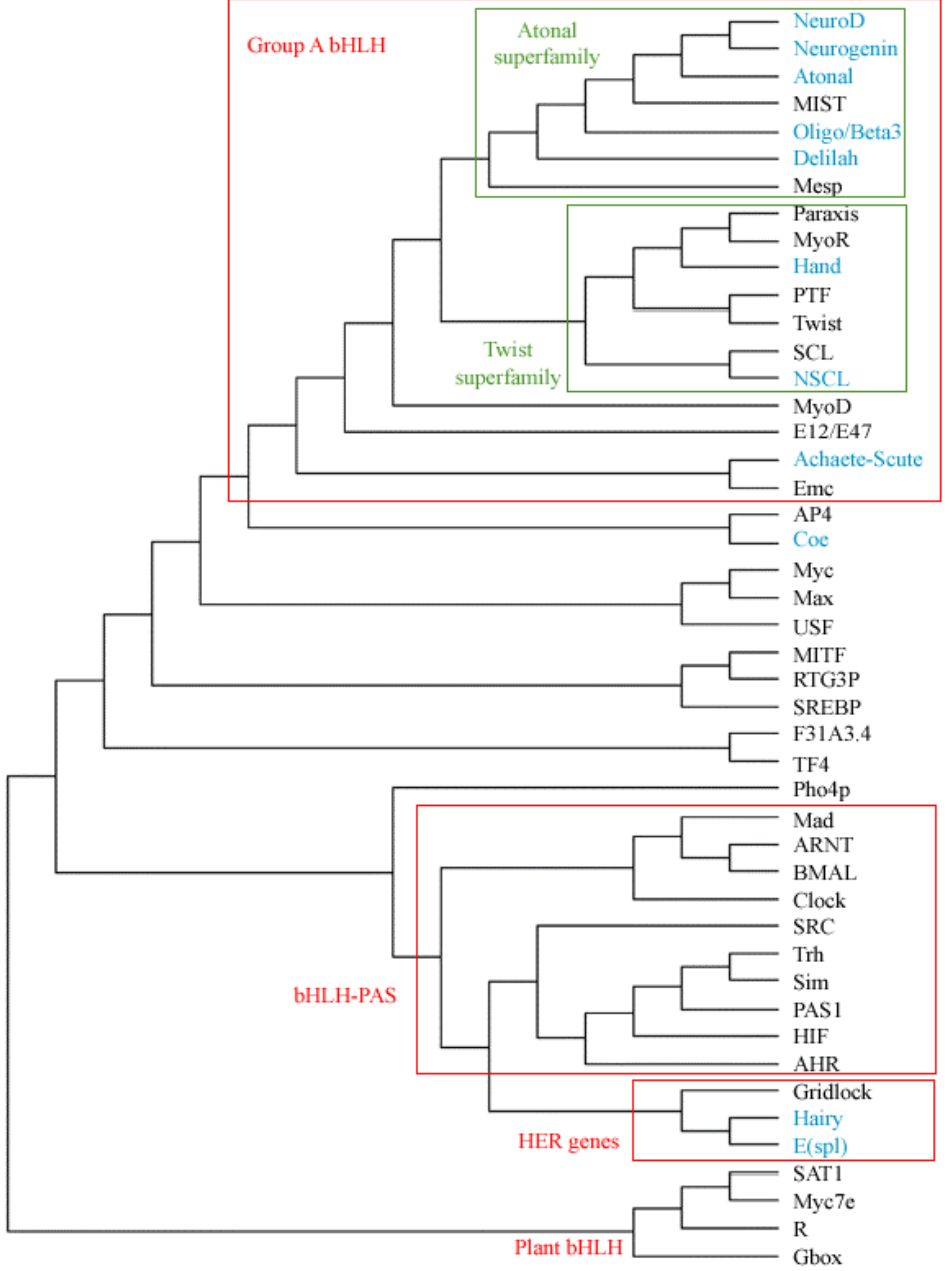
FIGURE 1. The 44 bHLH families and their evolutionary relationships . A NJ tree constructed using one gene (usually from mouse) per family, as well as the orphan D. melanogaster delilah gene and F31A3.4 (as a representative of a group of 3 C. elegans genes that cluster toghether with high bootstrap value). Families have been named according to their first discovered member, or in a few cases, to their best-characterized member[ 4 ]. To clearly represent the relationships at the tip of the branches, we display a rooted tree where the four plant bHLH families where taken as outgroup. This tree is just a representation of an unrooted tree with rooting that should be considered as arbitrary. For similar sake of simplicity, we show a tree in which branch lengths are not proportional to distances between sequences. Additional information can be found in Ledent and Vervoort[ 4 ] and on our web site http://www.cnrs-gif.fr/cgm/evodevo/bhlh/index.html . Families that contain proteins discussed in the review are coloured in blue. High-order grouping of the bHLH families is indicated. Group A includes related bHLH with similar biochemical properties, most of which being grouped into two superfamilies, Atonal and Twist. Other high-order groups are indicated such as bHLH-PAS, HER proteins and bHLH from plants . See Ledent and Vervoort[ 4 ] for details.